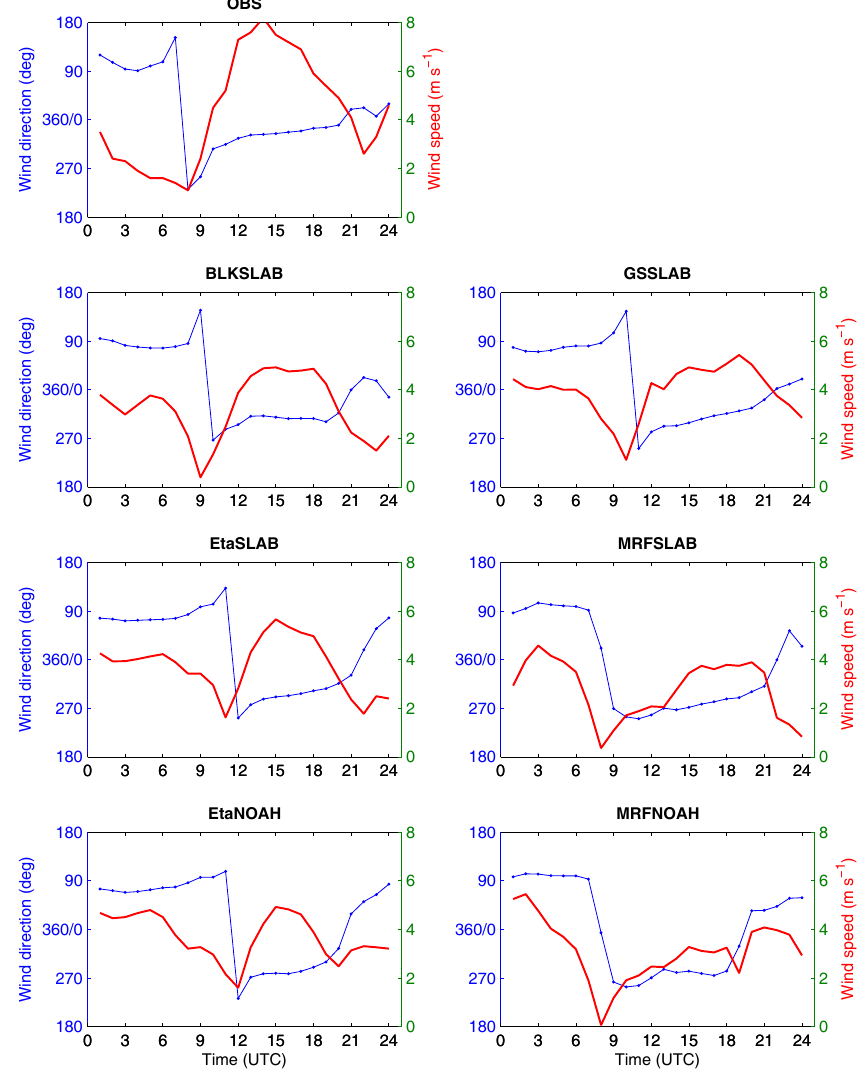
Fig. 3. Same as Fig. 2 but at Risholmen